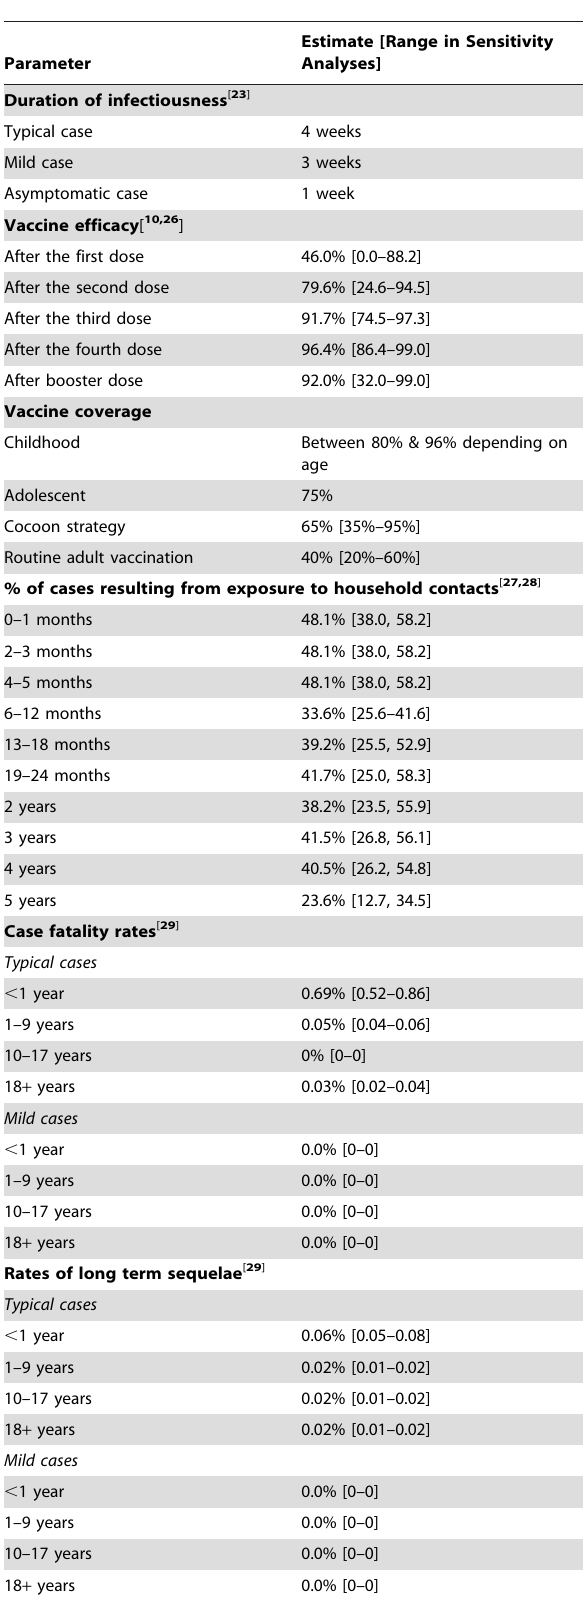
Table 2. Key parameters in the epidemiological model.